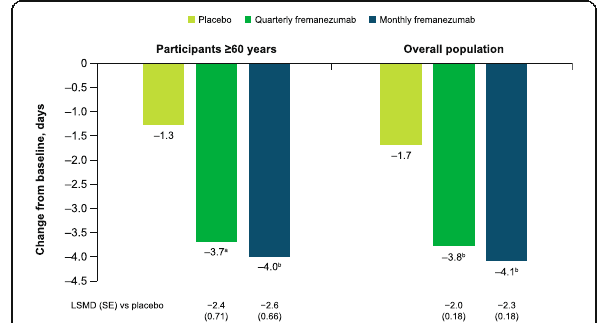
Fig. 5 Change in monthly days of acute medication use in participants aged ≥ 60 years and overall population. LSM, least- squares mean; LSMD, least-squares mean difference; SE, standard error. Data shown are the LSM changes from baseline in the monthly average number of days of acute headache medication use during 12 weeks of double-blind treatment. a P < 0.001 vs placebo. b P ≤ 0.0001 vs placebo